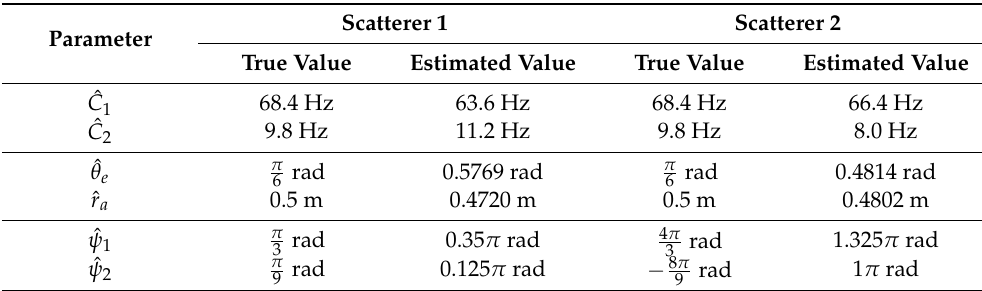
Table 5. The decomposition results of the OMP algorithm and parameter estimation results when the SNR is − 5 dB.